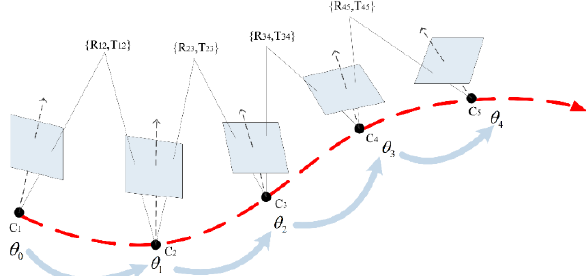
Fig.2 The workflow of computing azimuth from video